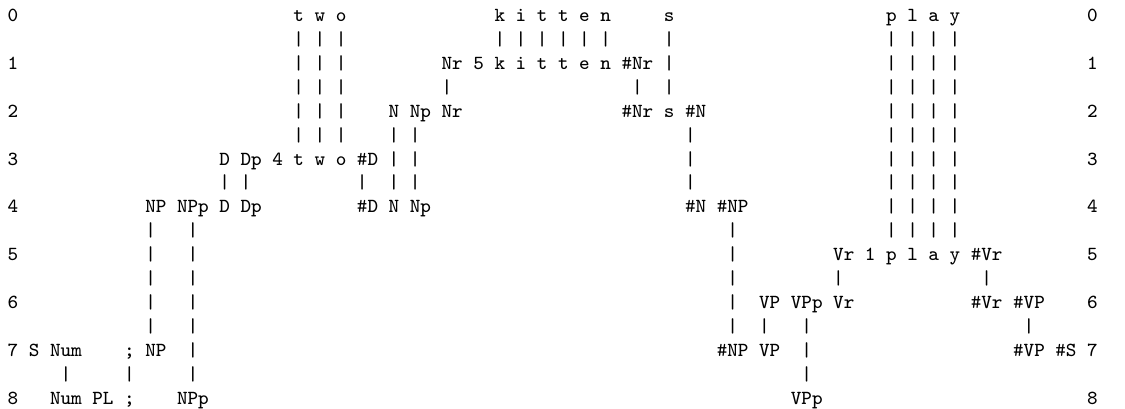
Figure A3. The best SPMA created by the SPCM with a store of Old SP-patterns like those in rows 1 to 8 (representing syntactic structures, including words) and a New SP-pattern, ‘ t w o k i t t e n s p l a y ’, shown in row 0, representing a sentence to be parsed. The SP-pattern in row 8 is concerned with syntactic dependencies as described in Section 4.1.2. Adapted from Figure 1 in